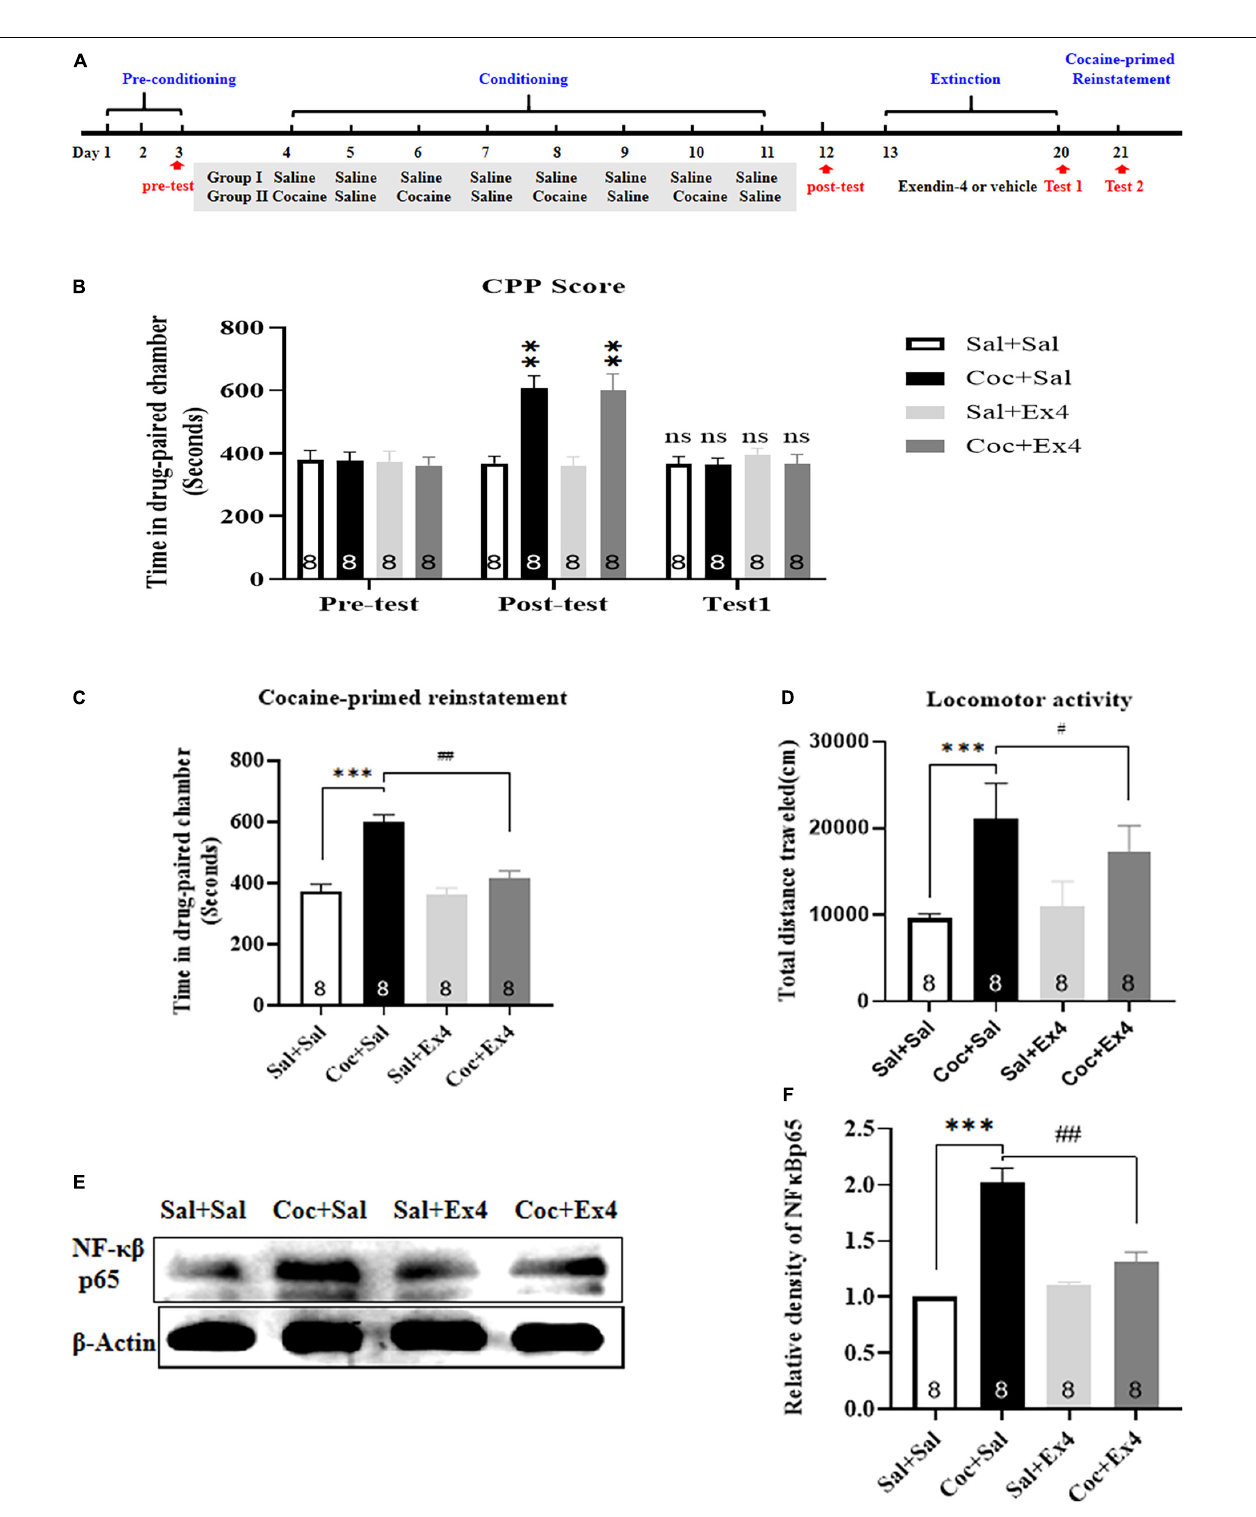
FIGURE 1 | The systemic pretreatment with exendin-4 prevented cocaine-primed reinstatement of cocaine-induced CPP. (A) The experimental schedule for saline as well as cocaine and exendin-4 treatments. (B) After cocaine conditioning, animals displayed a significant place preference for the cocaine-paired compartment. ∗∗ represents p < 0.01 vs Sal + Sal group, n = 8 each group, two-way rmANOVA. Additionally, CPP scores after vehicle or exendin-4 administration suggested that the cocaine-induced CPP was completely extinguished after 8 days extinction training. ns represents no significant, difference, n = 8 each group, two- way rmANOVA followed by Dunnett’s multiple comparisons test. (C) The systemic pretreatment with exendin-4 significantly prevented cocaine-primed reinstatement of